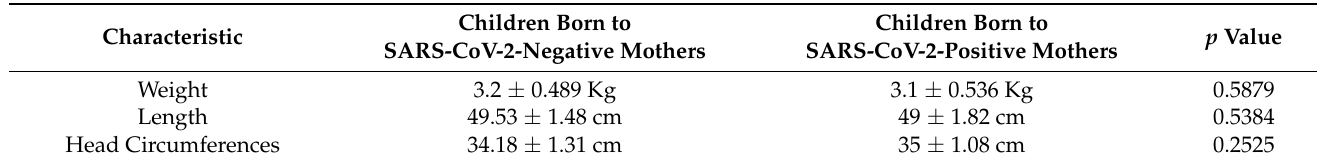
Table 2. Characteristics of the newborns. Anthropometric characteristics of newborns are expressed as mean ( ± SD).